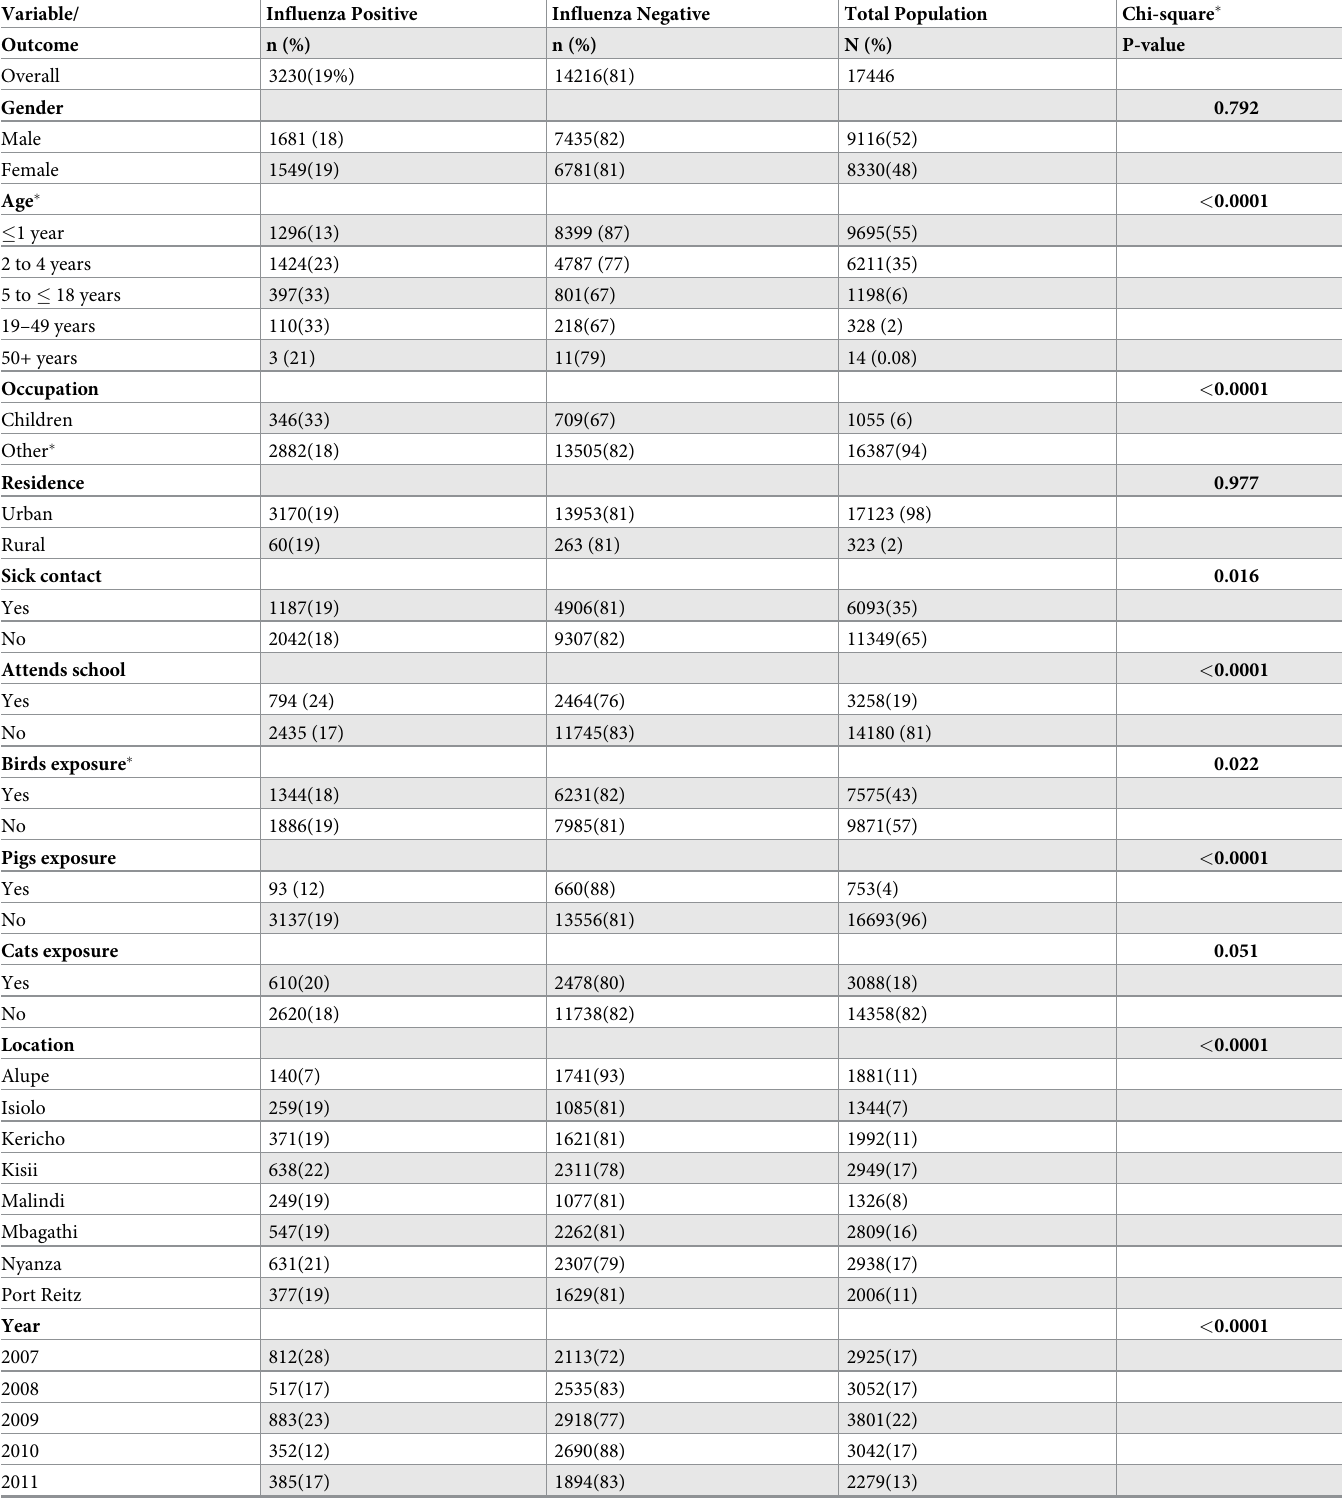
Table 1. Demographic characteristics of the study participants by influenza virus